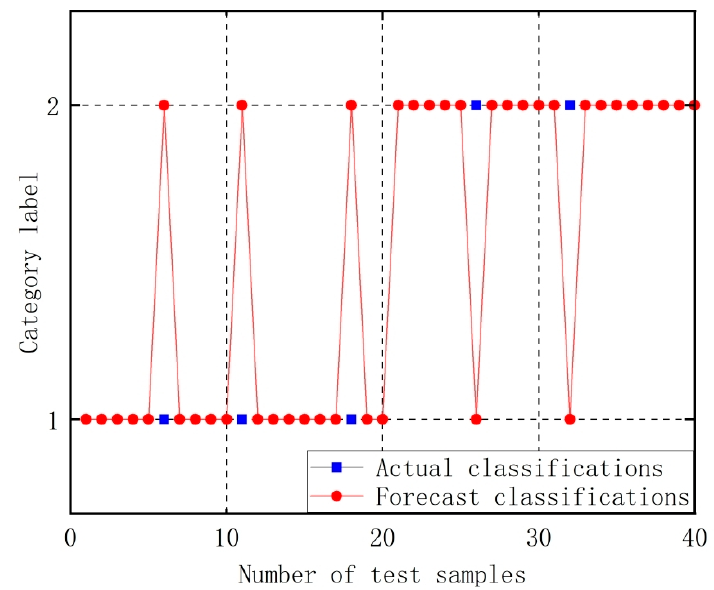
Figure 7. Anchor smash fault identification results based on the EMD–Volterra–SVM method.